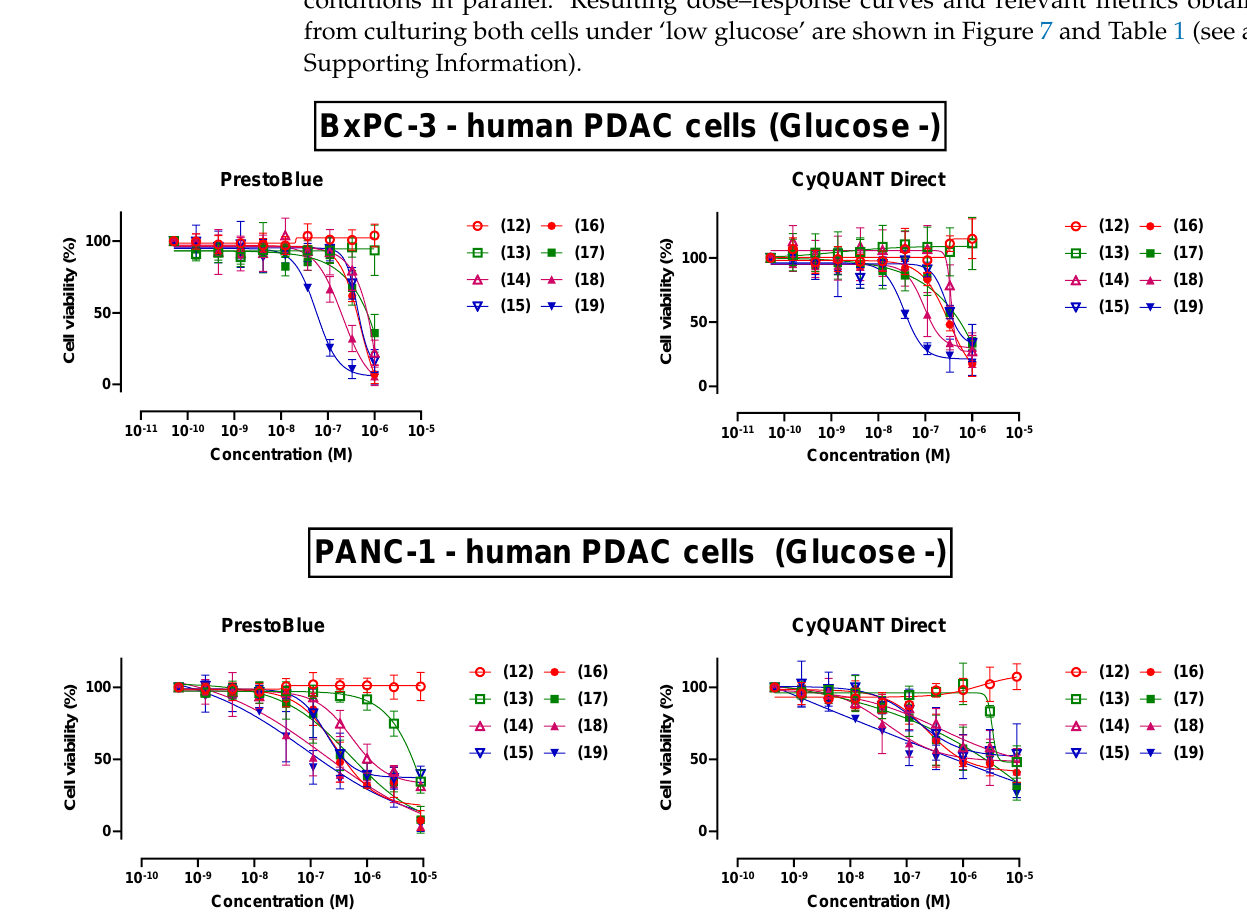
Figure 7. Comparative percent viability of BxPC-3 and PANC-1 cells cultured under ‘low glucose’ (Glucose − ) following a 24 h exposure to trichoderin A analogues ( 12 )–( 19 ), as judged by the Presto- Blue™ and CyQUANT™ Direct